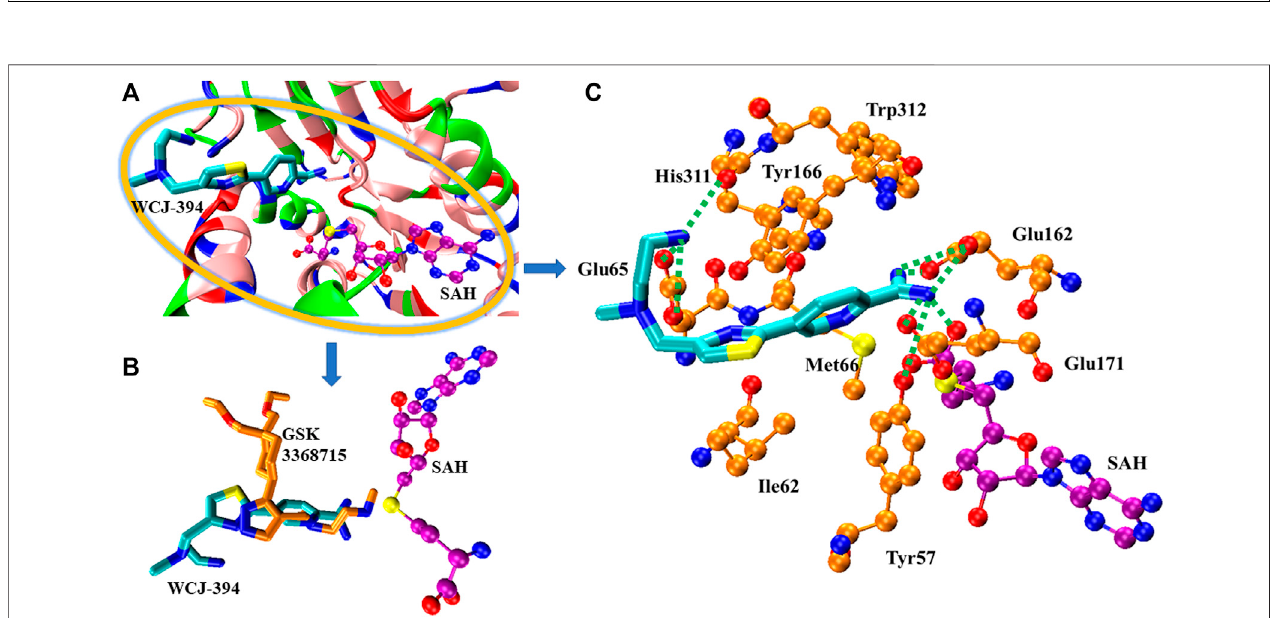
FIGURE 7 | The binding of WCJ-394 with PRMT1. (A) The overview of the binding of WCJ-394 with PRMT1-SAH. In the current fi gure, the basic residues were coloredinblue,theacidicresidueswerecoloredinred,thepolarresidueswerecoloredingreen,andthenonpolarresidueswerecoloredinpink.SAHwasrepresentedin ball – sticksmodel,inwhichtheoxygenatomswerecoloredinred,thenitrogenatomswerecoloredinblue,thesulfuratomswerecoloredinyellow,andthecarbonatoms werecoloredinpurpleunlessotherwisespeci fi ed.WCJ-394wasrepresentedinsticksmodel,inwhichthecarbonatomswerecoloredincyan. (B) Thecomparison ofthebindingposesofWCJ-394andGSK3368715(carbonatoms ingold). (C) TheinteractionsofWCJ-394withPRMT1-SAH.Thehydrogen bondswererepresented in dotted lines, and the key residues were represented in ball – sticks model and carbons were in gold.